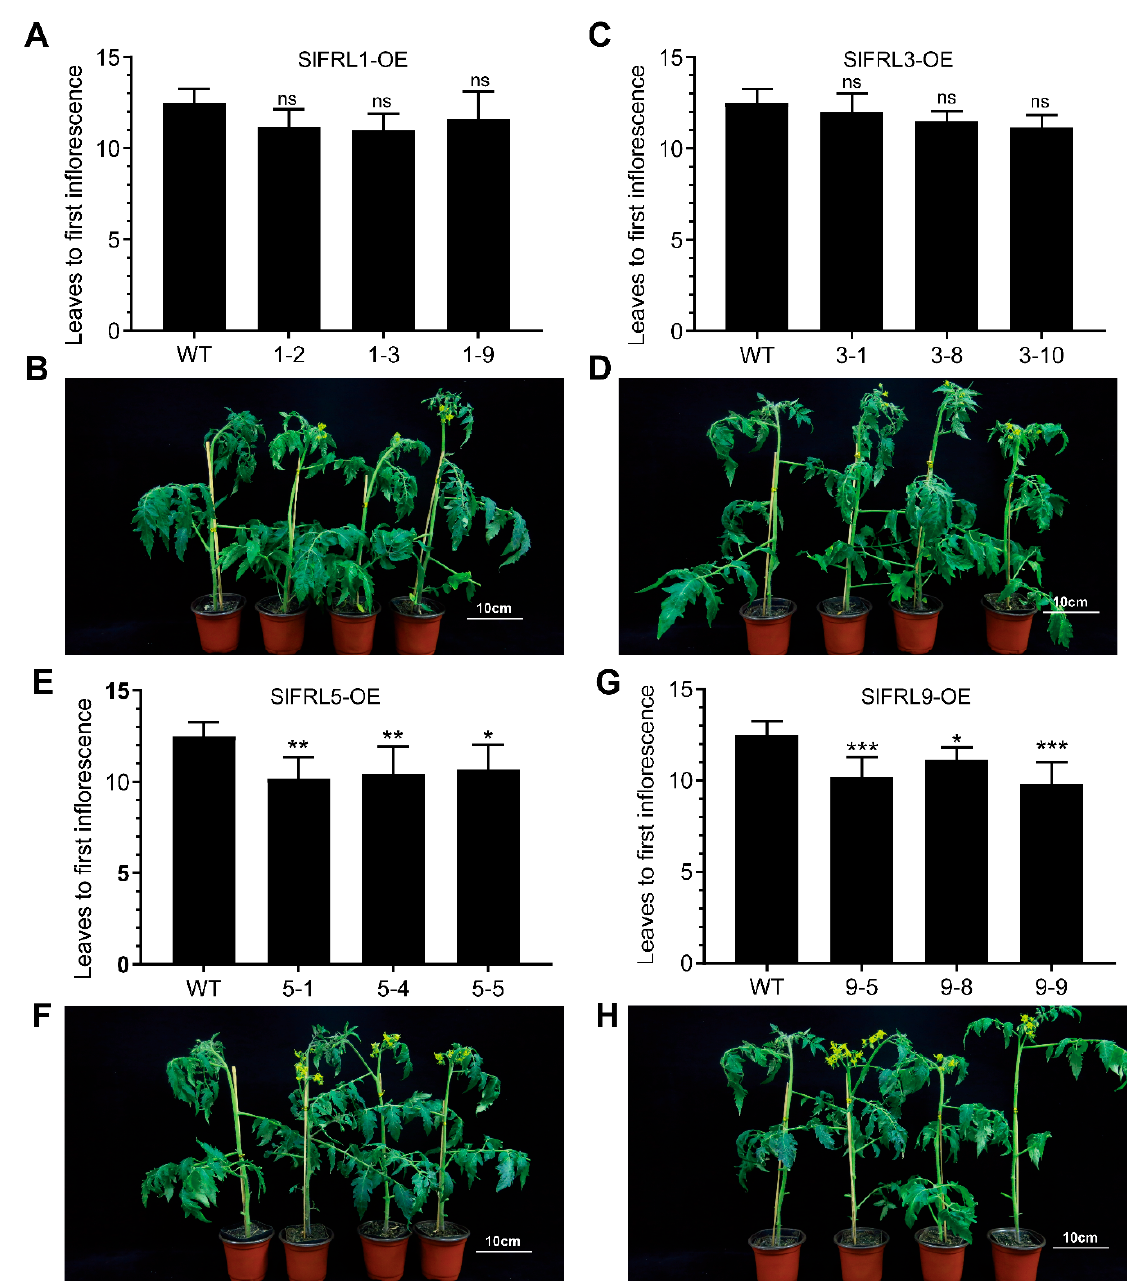
Figure 8. Overexpression SlFRL5 or SlFRL9 caused early flowering phenotype in tomato. ( B , D , F , H ) are the flowering pictures of SlFRL1 ‐ OE , SlFRL3 ‐ OE , SlFRL5 ‐ OE and SlFRL9 ‐ OE lines, respectively. ( A , C , E , G ) are the number of true leaves under the first panicle. n ≥ 6. In the figure one star (*) stand for 5% level of significance while 2 stars (**) for 1% and 3 stars (***) for 0.1% level of significance. Virus ‐ mediated gene silencing ( VIGS ) was used to obtain transiently silenced SlFRL tomato plants. Albino type leaves were found in TRV2 ‐ SlPDS positive plants, indicating